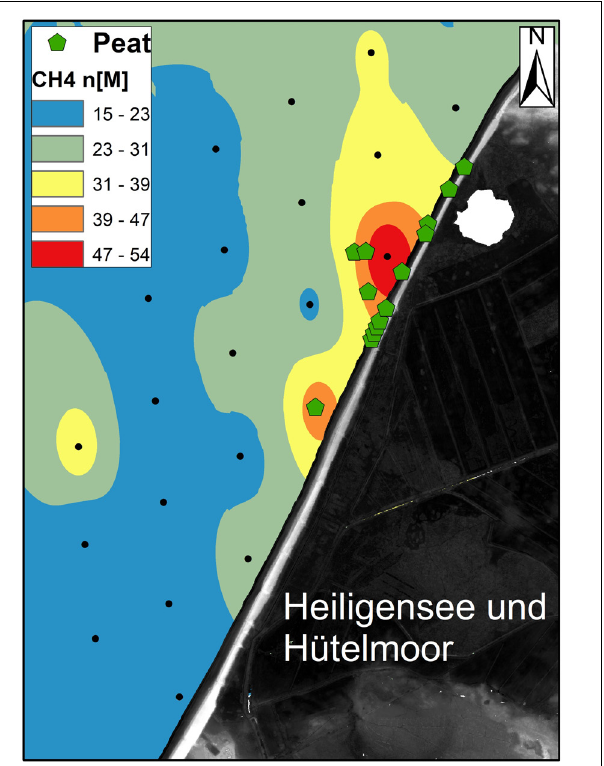
FIGURE 12 | Dissolved methane distribution in the shallow Baltic Sea in front of the study site, composite of several measurements in June